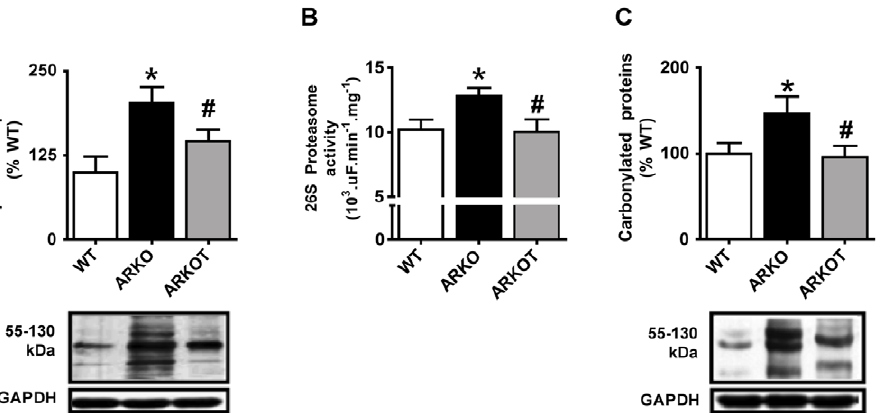
Figure 4. UPS activation and effects of AET. Protein ubiquitination (A), chymotrypsin-like proteasome activity (B) and protein carbonylation (C) in 7 month-old wild type (WT), untrained a 2A / a 2C ARKO (ARKO) and trained a 2A / a 2C ARKO mice (ARKOT). Representative images of immunoblots are shown below respective charts. Data are shown as percentage of WT control group values (set to 100%) and presented as mean 6 standard error from mean. *p , 0.05 vs. age-matched WT; # p , 0.05 vs. age-matched ARKO.